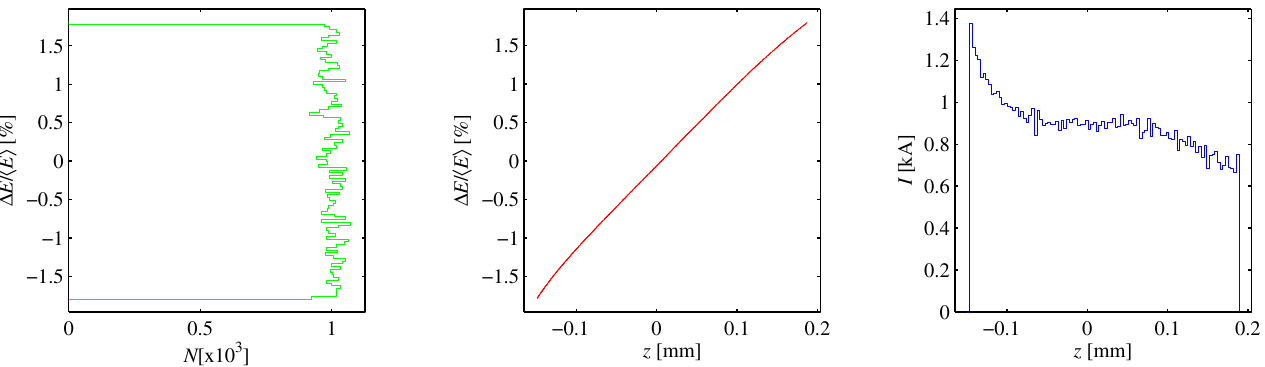
FIG. 9. (Color) Energy profile (left), longitudinal phase space (middle), and bunch current distribution (right) after the bunch compressor when the passive linearizer is used to compensate the quadratic term. The goal is to have a compression factor C ¼ 6 .